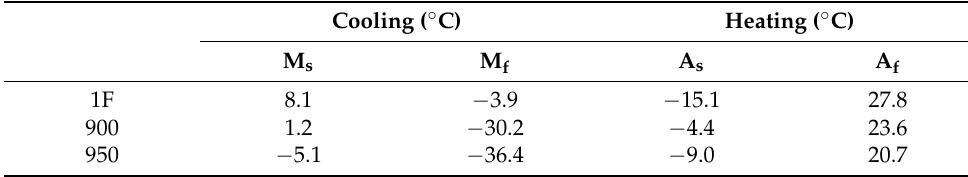
Table 1. Phase-transformation